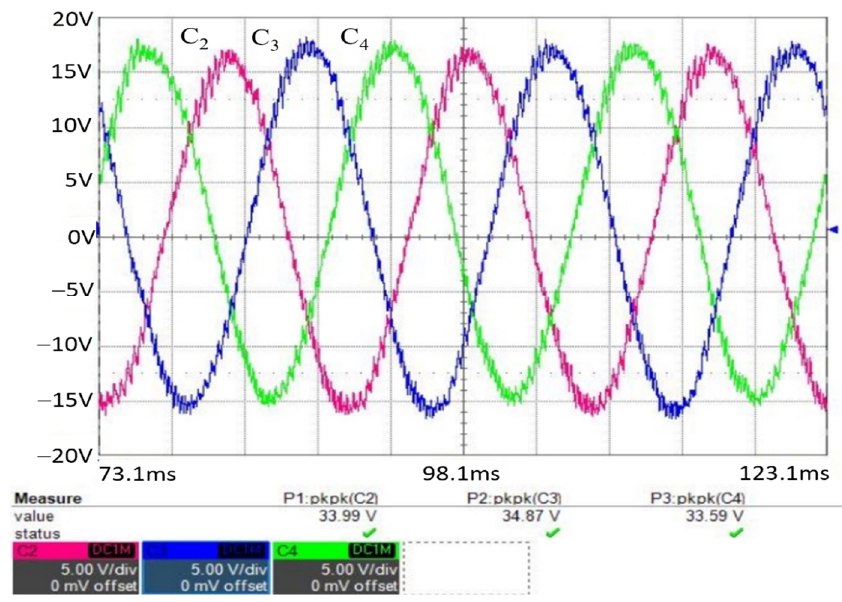
Figure 14. Three-phase output voltage waveforms .